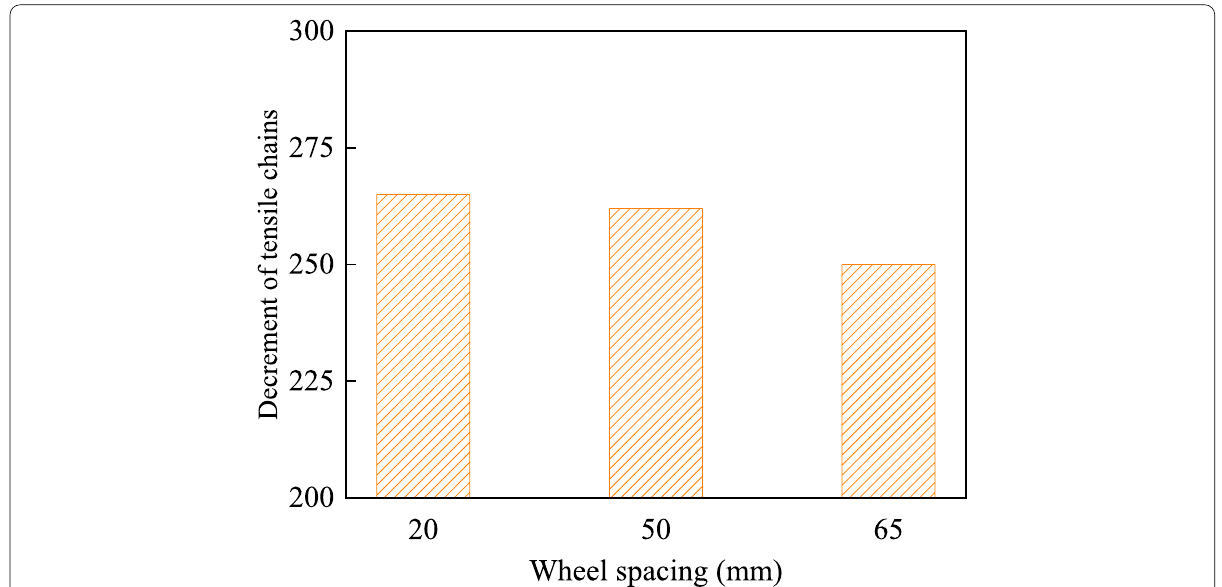
Fig. 16 Decrement of tensile chains with different wheel